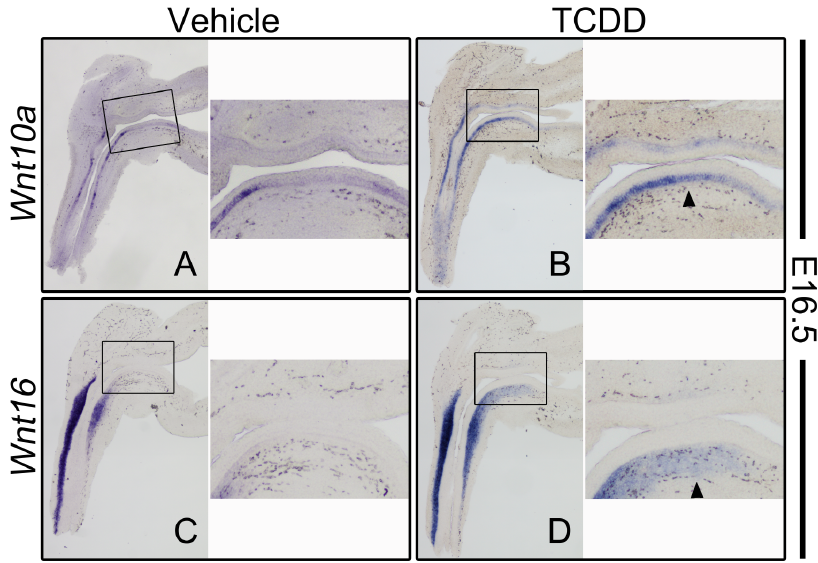
Figure 5. TCDD increases Wnt10a and Wnt16 RNA abundance in the ventral UGS. Sagittal sections from in vivo vehicle-exposed ( A , C ) and TCDD-exposed ( B , D ) UGSs were stained by ISH (purple stain). ( A ) At E16.5 in control tissues, little to no Wnt10a RNA was detected in the ventral UGS. ( B ) Wnt10a RNA was detected in the ventral basal epithelial cells of TCDD-exposed UGSs. ( C ) At E16.5, little to no Wnt16 RNA was detected in the ventral region of control UGSs. ( D ) Wnt16 RNA was detected in the ventral mesenchyme of TCDD-exposed UGSs. Arrowheads point to de novo staining detected in the ventral UGS of TCDD-exposed UGSs. Reprinted from [152] with permission from Oxford University